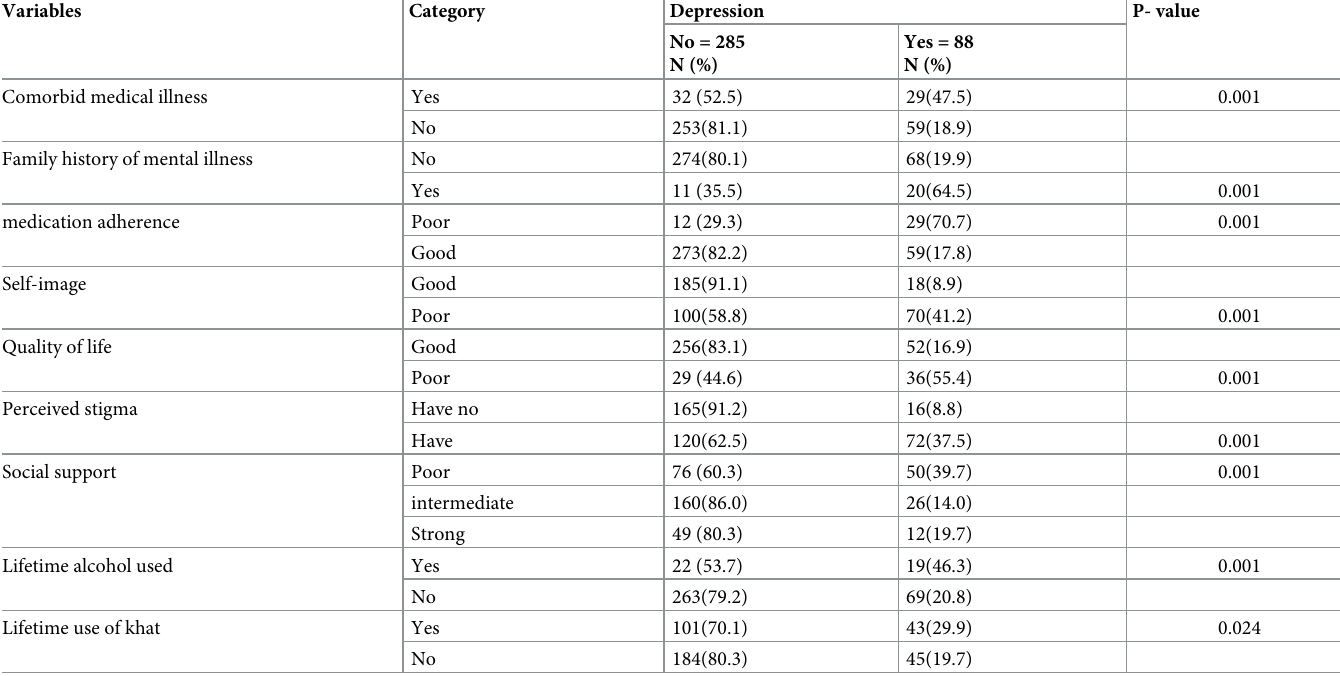
Table 2. Distributions of clinical and psycho-social characteristics of respondants depression status with chronic skin disease attending at Boru Meda General Hos- pitals, Northeast Ethiopia (N =